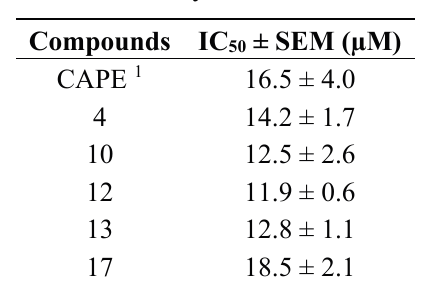
Table 1. Antioxidant activity of selected CAPE